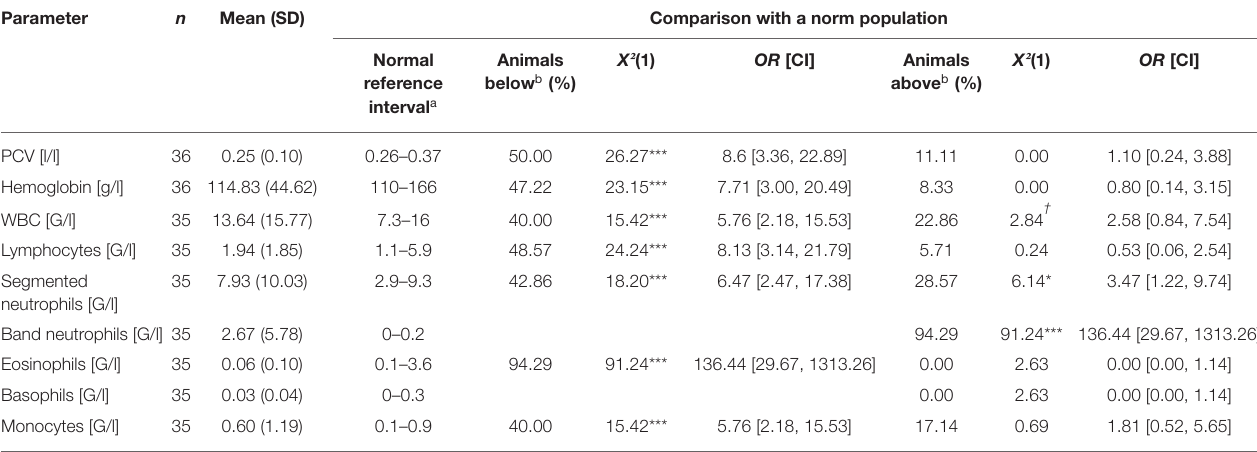
TABLE 5 | Average blood values of deceased alpacas with gastric ulcers ( n = 44) and comparison with a norm population. Parameter n Mean (SD) Comparison with a norm population